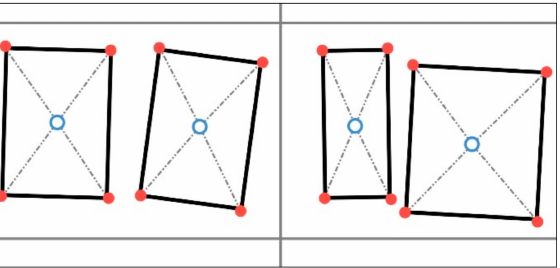
Figure 5. Buildings (black continuous), point sets (red), centroids (blue), Dist C (grey dashed), and streets (grey continuous).